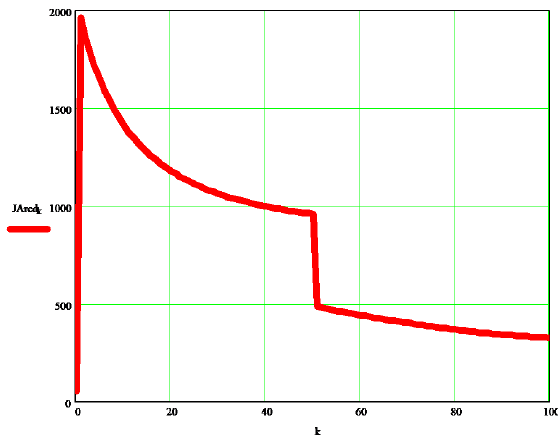
Figure 3. Variations of mass (mechanical) moments of inertia reduced to a coupling A (element 1).